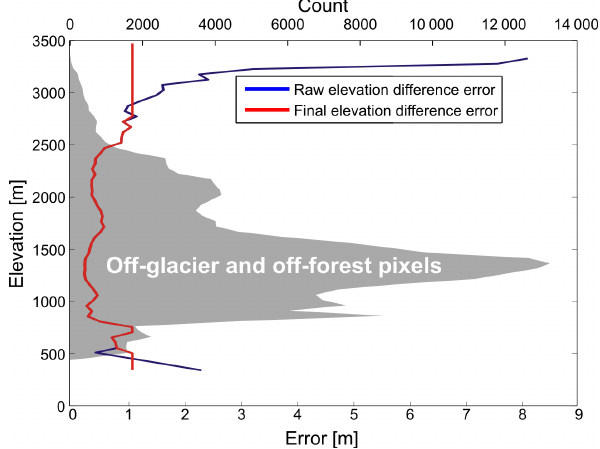
Figure 4. E(cid:49)h distribution with altitude, the grey area represents the number of pixels off-glacier and off-forest in each elevation band. At very low (<500ma.s.l.) and high (>2700ma.s.l.) eleva- tions the raw error increases, an artefact associated with the lower number of values available. The red line represents the E(cid:49)h used to calculate the error of the geodetic mass balance estimation of Monte Tronador